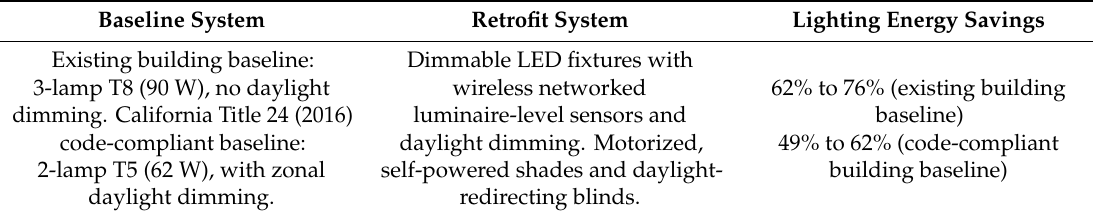
Table 5. Test System 2 characteristics and energy